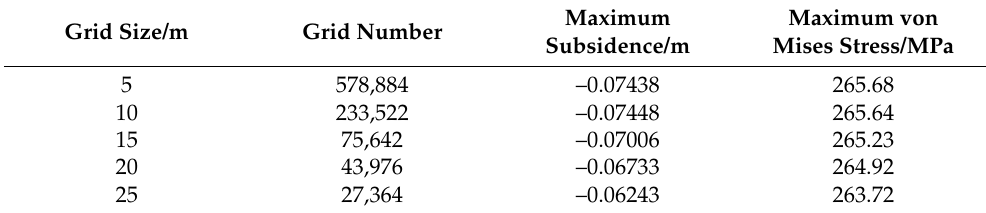
Table 2. Mesh sensitivity analysis results.